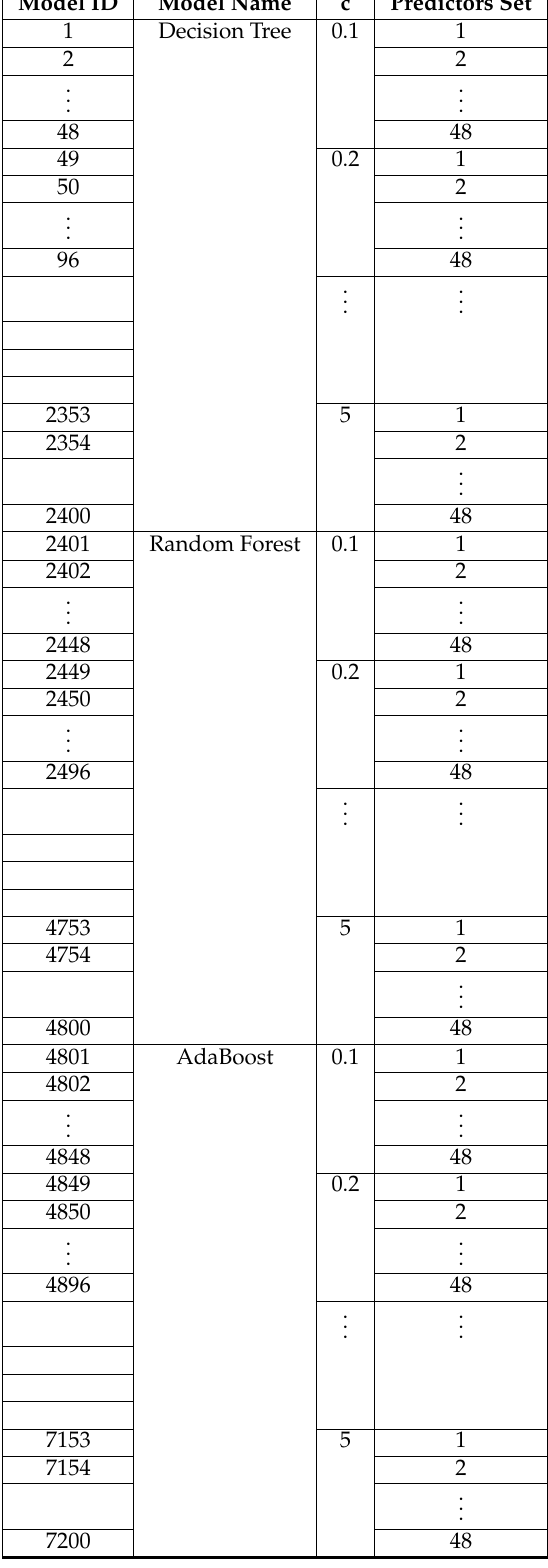
Table 13. Predictors Sets 1–24 use integer difference close price as the last feature for each candlestick, while Predictors Sets 25–48 use fractional difference close prices